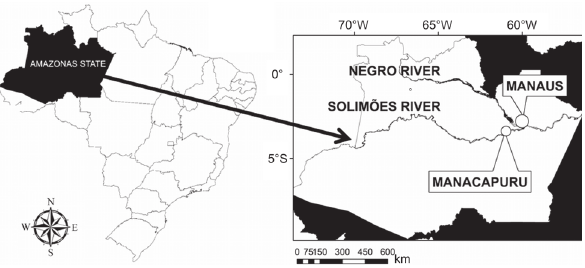
Figure 1. Location of Manacapuru on the map of Amazonas,